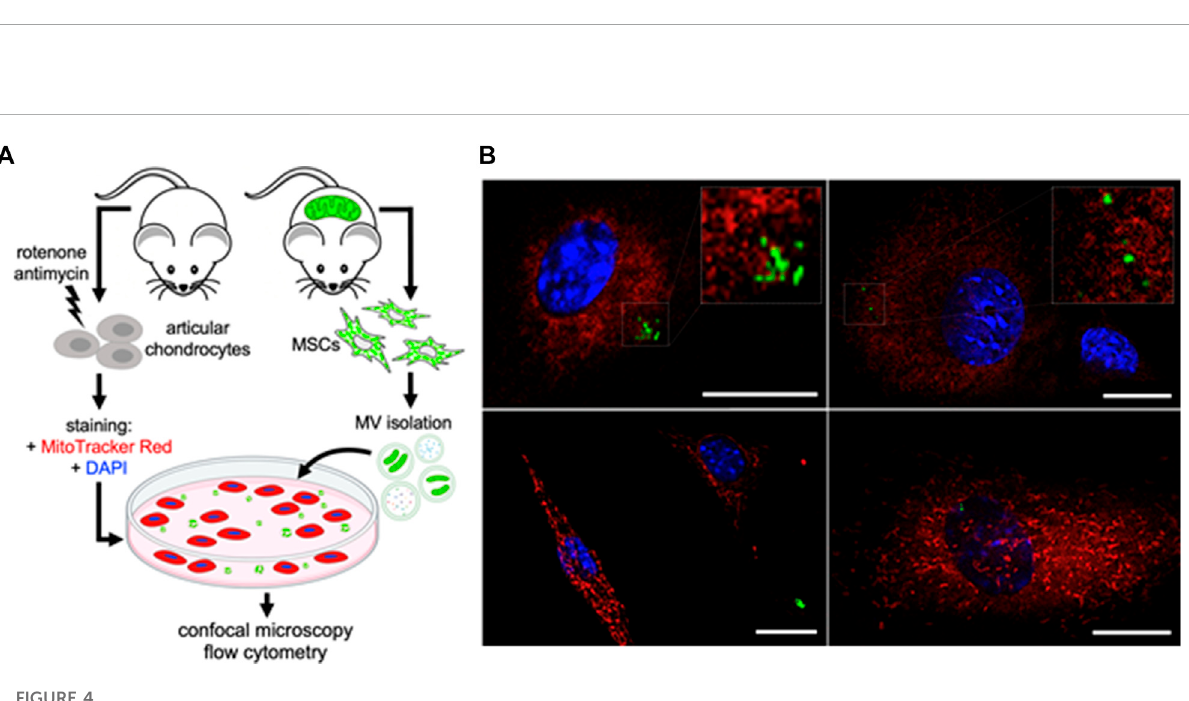
FIGURE 3 A subset of MitoEVs contain functional mitochondria. (A) Representative fl ow plot identifying polarized mitoEVs; events fl uorescing above control thresholds for calcein AM (green) and TMRM (orange) were classi fi ed as mitoEVs containing functional MT (red). (B) . Quanti fi cation of functional mitoEVs (red-green double positive events) and three control groups; TMRM only ( ▲ ), calcein only ( ■ ), and unstained control ( ▼ ), compared to EVs stained with calcein + TMRM ( C ). Data is expressed as the fraction of double-positive events in each group. of percent red/ green double positive showed statistically signi fi cant differences between the double stained experimental group and single color/unstained controls Groups that do not share a letter are signi fi cantly different ( n = 3, p ≤ 0.05) by one-way